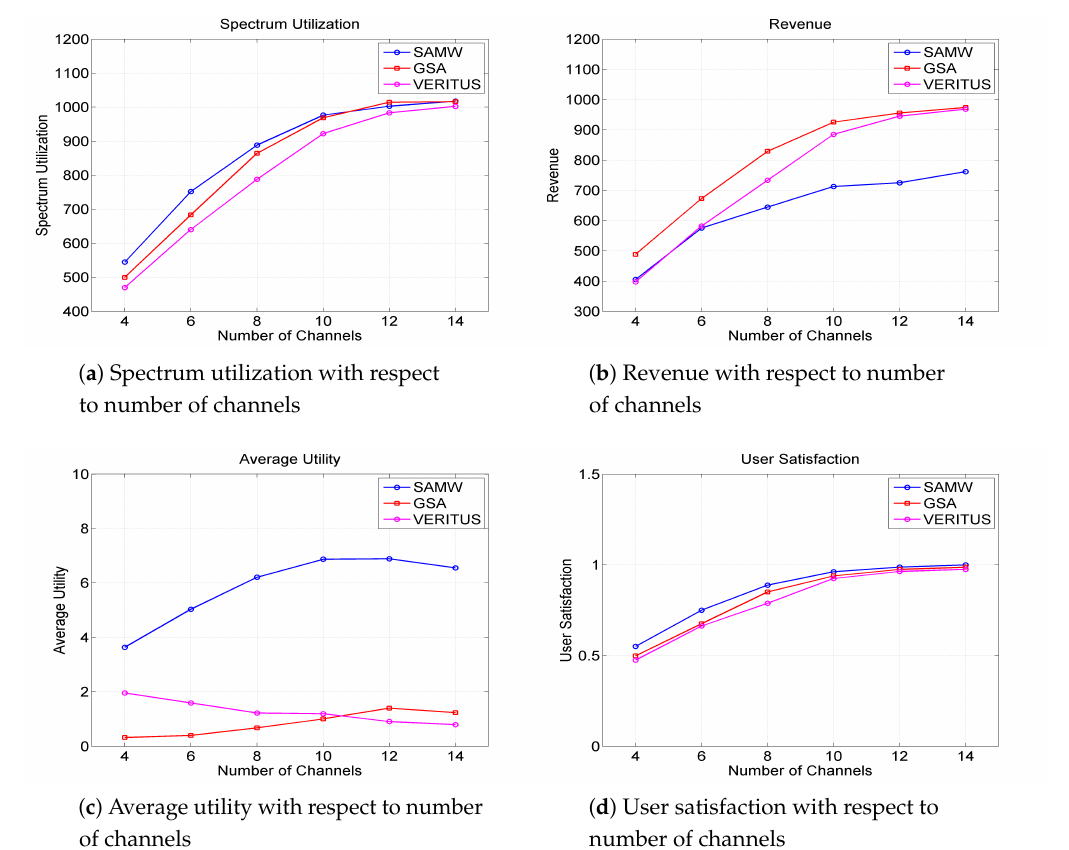
Figure 6. Spectrum utilization, revenue, average utility, and user satisfaction for sequential auction-based multi-winner (SAMW), general sequential auction (GSA), and VERITUS with respect to number of